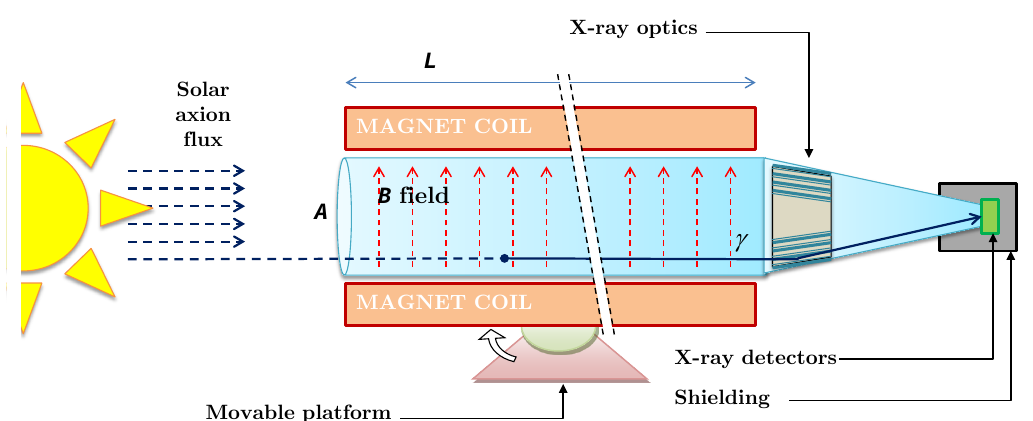
Figure 9: Conceptual arrangement of an enhancged axion helioscope with X-ray focussing. Solar axions are converted into photons by the transverse magnetic field inside the bore of a powerful magnet. The resulting quasi-parallel beam of photons of cross sectional area A is concentrated by an appropriate X-ray optics onto a small spot area a in a low background detector. Figure taken from [ 212 ]